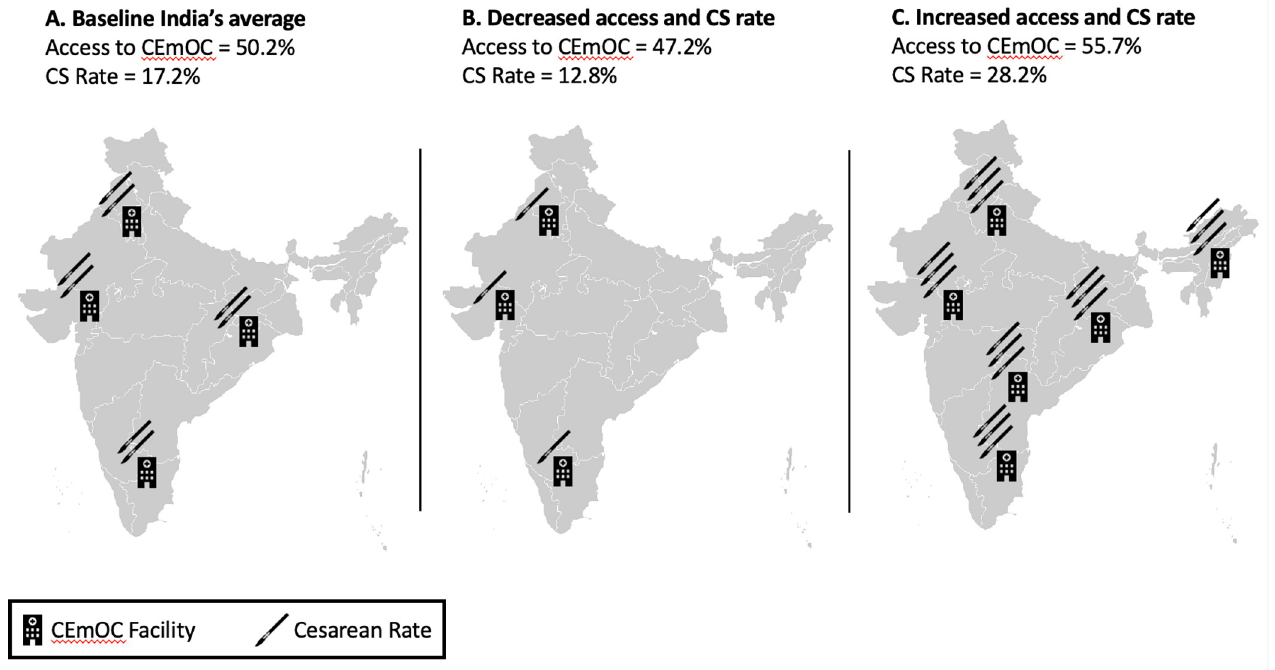
Fig 1. Strategies to scale up CS care. Graphic representation of the three strategies: [A] is the baseline strategy with India’s national average access to CEmOC and average CS rate; [B] is the strategy that reflects India’s current access to CEmOC and CS rates in rural areas, which are poor and adequate, respectively; [C] is the strategy that reflects India’s current CEmOC access and CS rates in urban areas, which have better access to CEmOC than the average and a higher CS rate than the rest of India. The facilities icon represent access to CEmOC, and the scalpels represents CS rate. The icons are a visual representation and do not illustrate proportional changes between the strategies. Base Layer from: https://commons.m.wikimedia.org/wiki/File:BlankMap-India2.92.png.